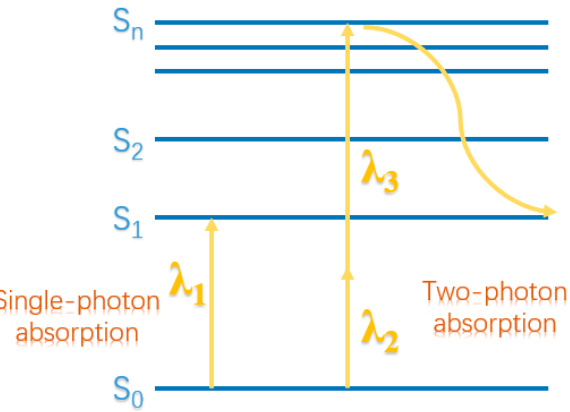
Figure 2. The difference between single-photon absorption and two-photon absorption.